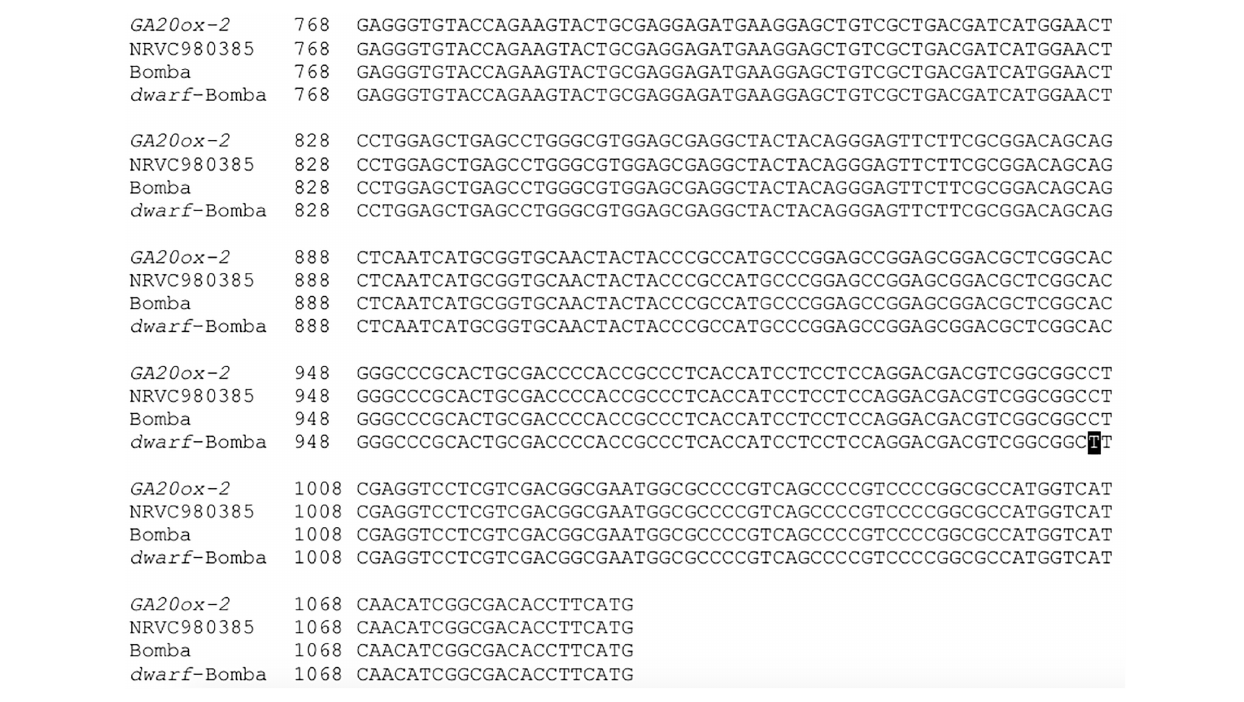
FIGURE 2 | Alignment of the second exon of GA20ox-2 , with the corresponding base numbers. The Calrose mutation present in dwarf -Bomba is blackened.